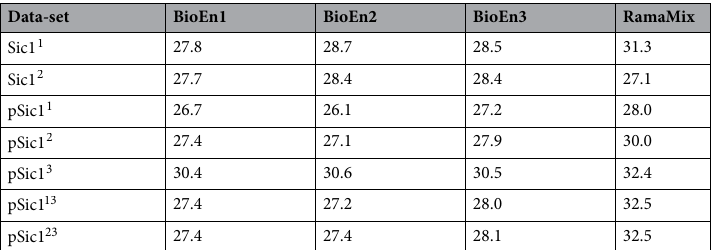
3 1 2 1 2 , Sic1 and pSic1 , pSic1 , pSic1 were 13 23 and pSic1 were 3 1 2 and pSic1 or the conformations of pSic1 and